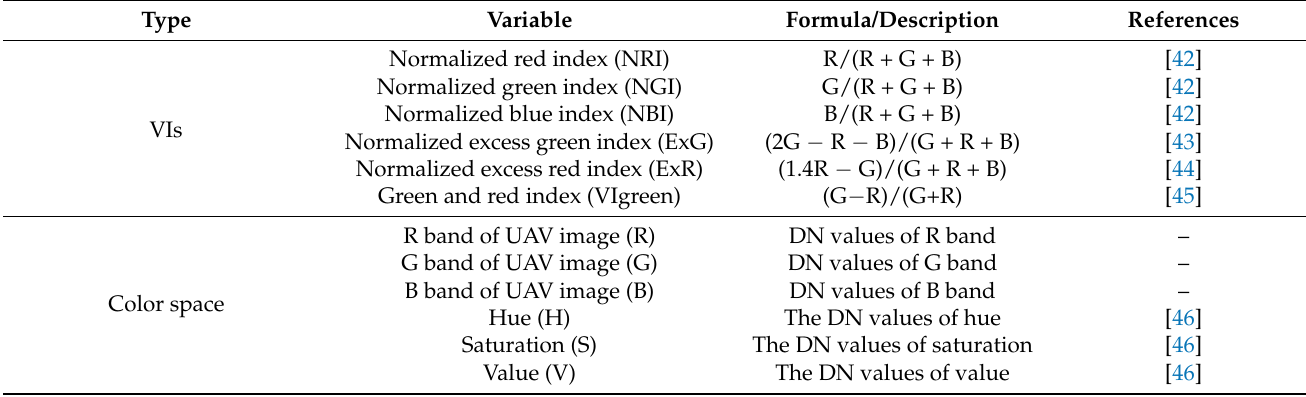
Table 2. Descriptions of VIs or color space derived from UAV-RGB